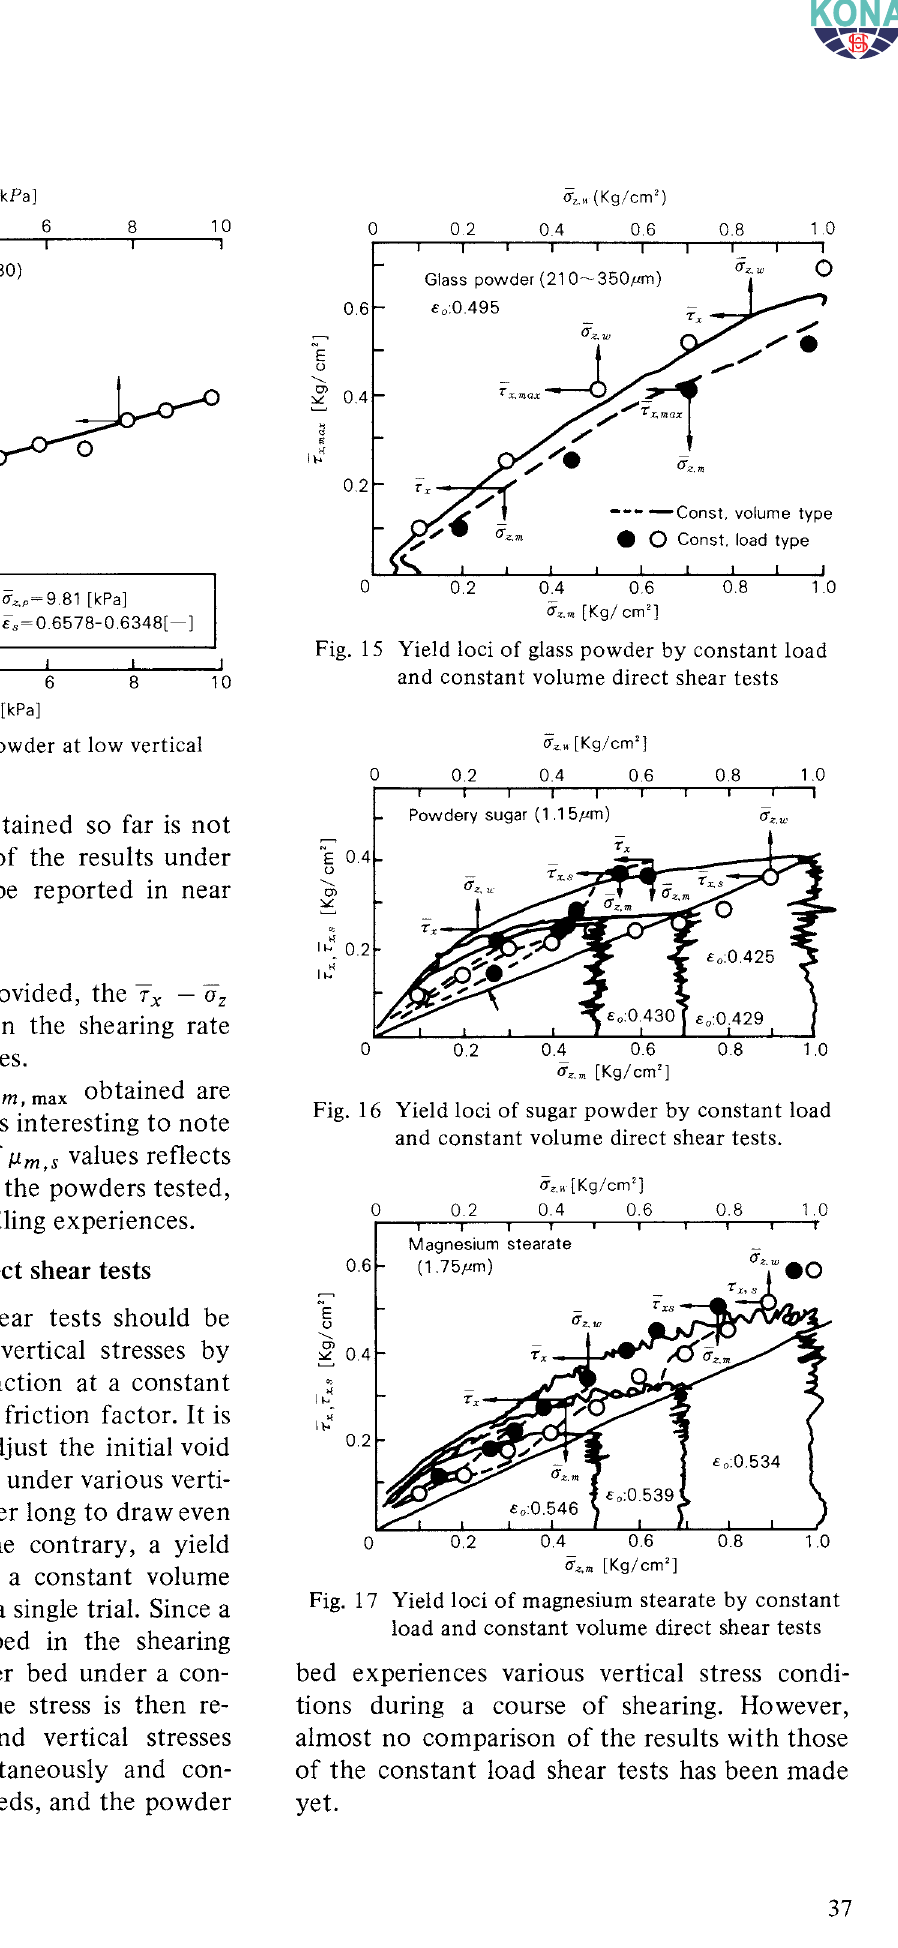
Fig. 15 Yield loci of glass powder by constant load and constant volume direct shear tests 10